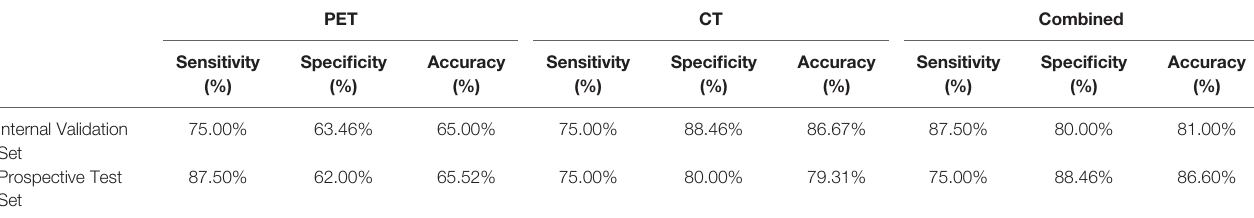
TABLE 3 | Performance of the three deep learning models. PET CT